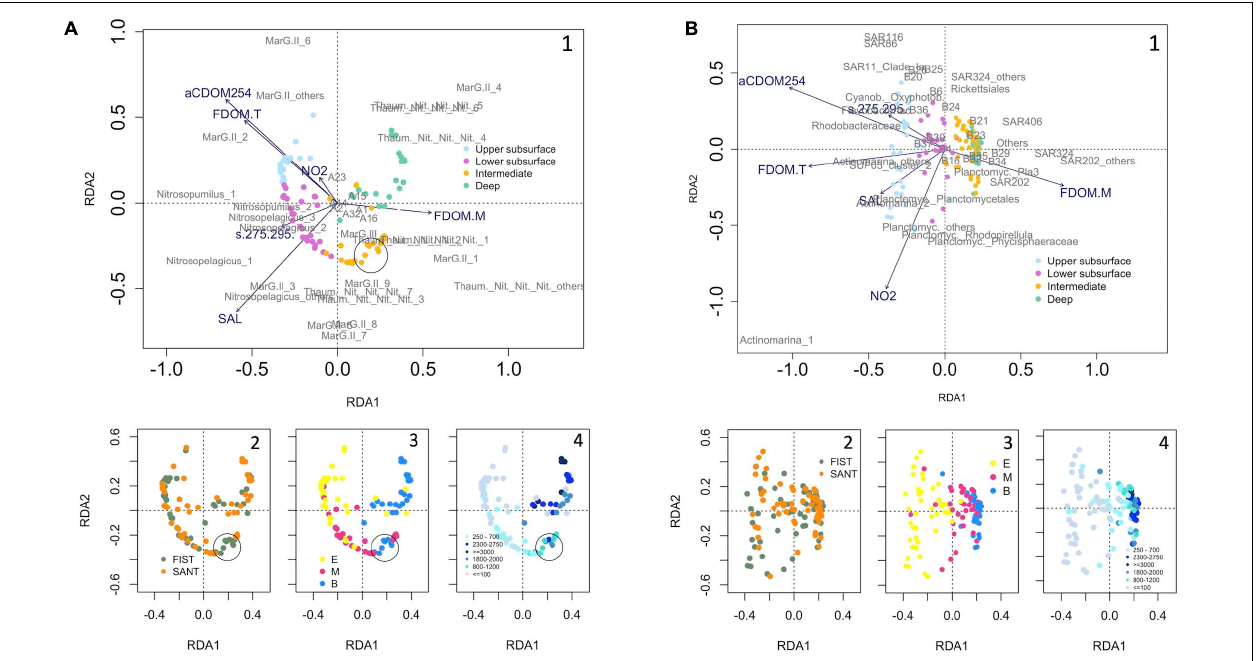
FIGURE 6 | Redundancy analysis (RDA) derived from Hellinger-standardized relative abundance for the abundant phylotypes of panels (A) Archaea and (B) Bacteria, and abiotic (environmental and DOM-related) variables, after removing collinear variables. The arrow length represents the strength of the correlation between the environmental variables and the samples. The longer the arrow length, the stronger the correlation. The perpendicular distance between the samples or the abundant phylotypes and the environmental variables reflects their correlations. The smaller the distance, the stronger the correlation. Samples are color-coded as a function of: (1) cluster, based on community dissimilarity (see Figure 4 for Archaea and Figure 5 for Bacteria); (2) transect (FIST = Fisterra, green, and SANT = Santander, orange); (3) depth realm [E = Epipelagic ( < 200 m), M = Mesopelagic (200–1000 m), and B = Bathypelagic ( > 1000 m)]; and (4) sampling depth range (m). See Tables 2 , 3 for further details on the taxonomy of abundant archaeal and bacterial phylotypes, respectively. Abbreviations in this figure: A1: Cren._Geothermarchaeac ; A2: Eury._Halomicrobiac. ; A14: Eury._Thermoc._Methanofast. ; A15: Nano._Woesearchaeia ; A16: Thaum._MarBenthicGA ; A23: C.Nitrosopumilus_others ; A32: Thaum._others ; B4: Actinob._Sva0996_marine_group ; B6: Flavobacter._others ; B16: OCS116 ; B20: AEGEAN-169_marine_group ; B21: Magnetospiraceae ; B23: SAR11_Clade_Ib ; B24: SAR11_Clade_II ; B25: SAR11_others ; B26: Proteob._Alphap._others ; B29: HOC36 ; B30: Pseudohongiella ; B32: SUP05_cluster_1 ; B34: SUP05_cluster_others ; B35: UBA10353_marine_group ; B36: Proteob._Gammap._others ; B37: Verrucomicrobiae